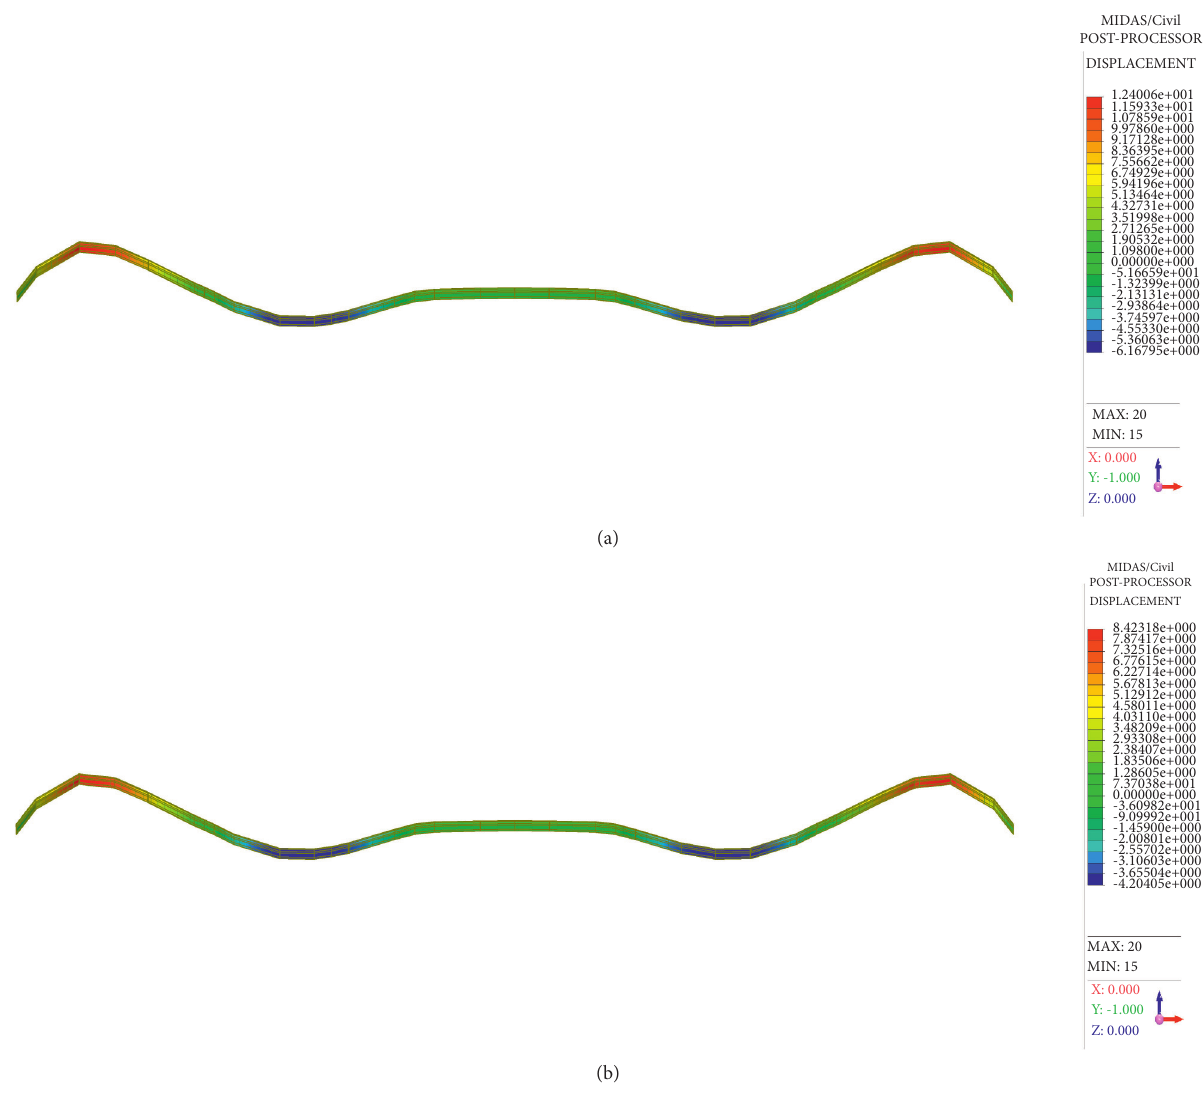
Figure 16: Displacement diagram of the steel-concrete composite beam under a temperature gradient. (a) Rise gradient displacement diagram. (b) Drop gradient displacement